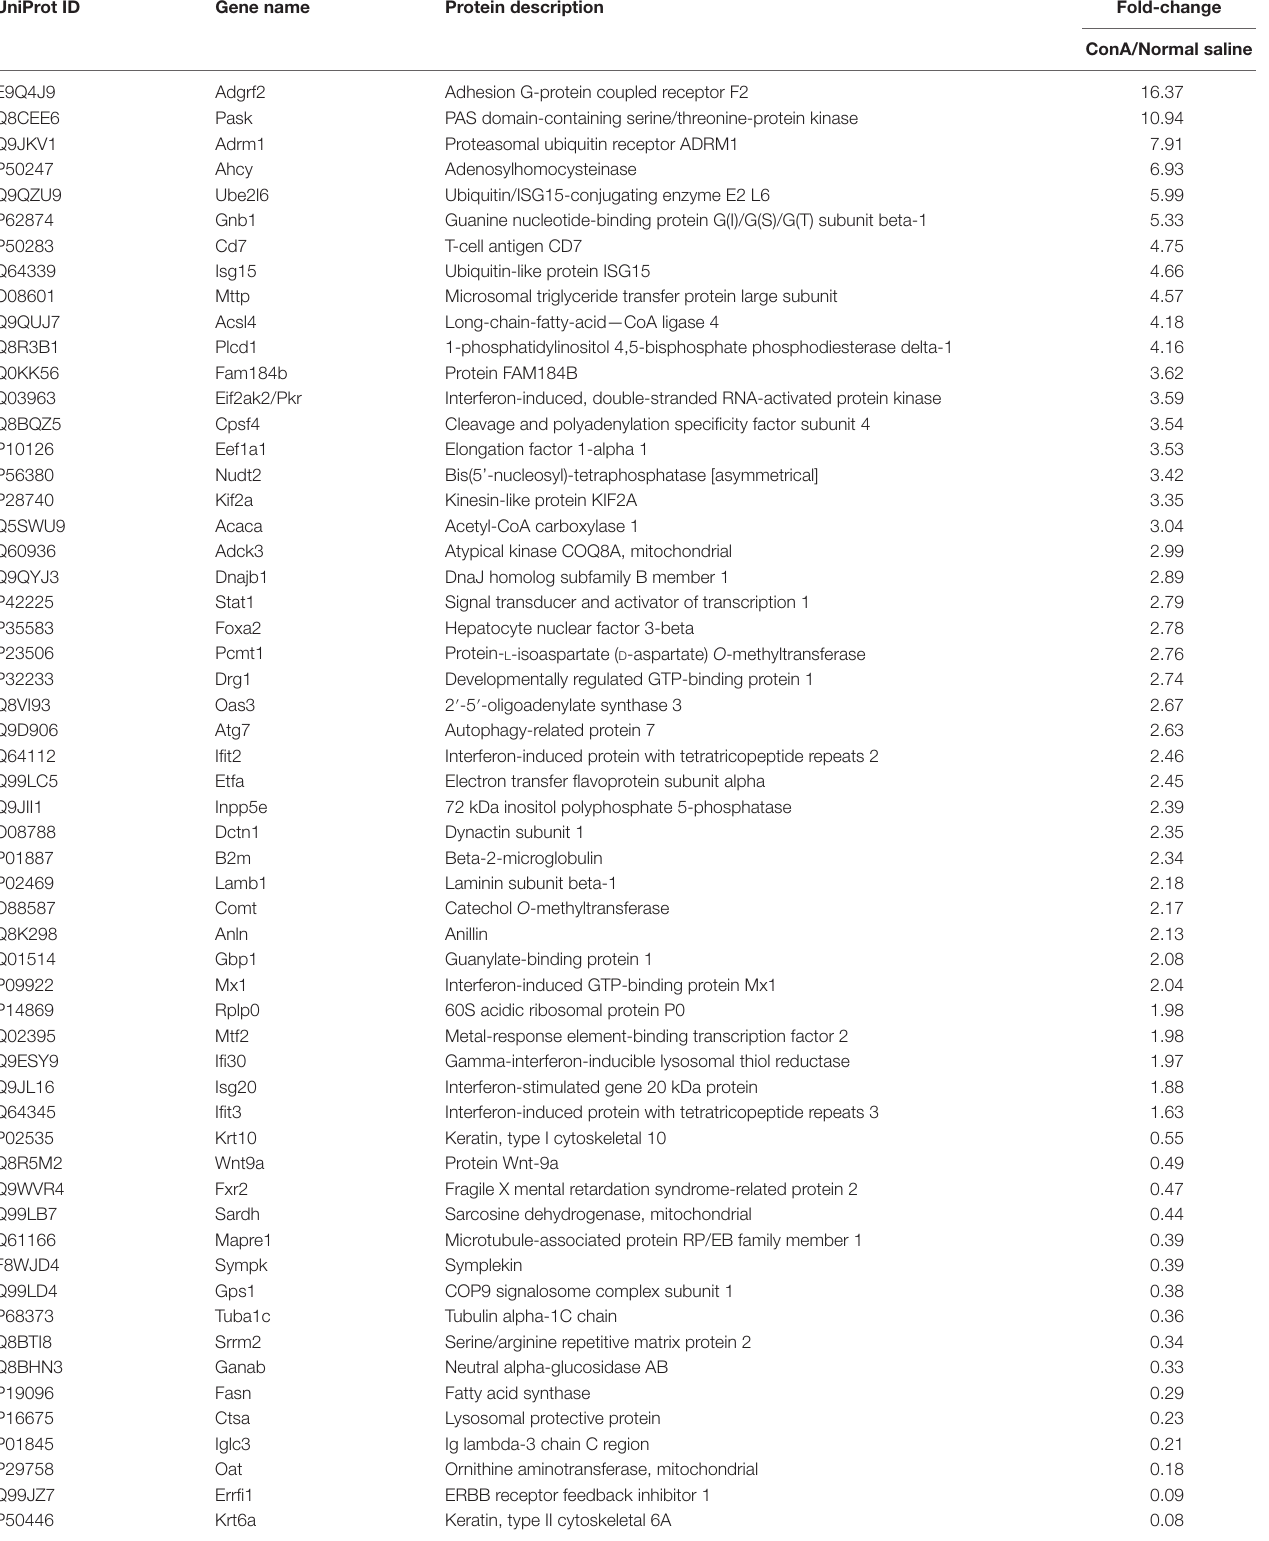
Table showed the mean fold changes of proteins in model mice versus normal mice with p values less than 0.05 (n = 3), where ratios > 1.25 were upregulation; ratios < 0.8 were